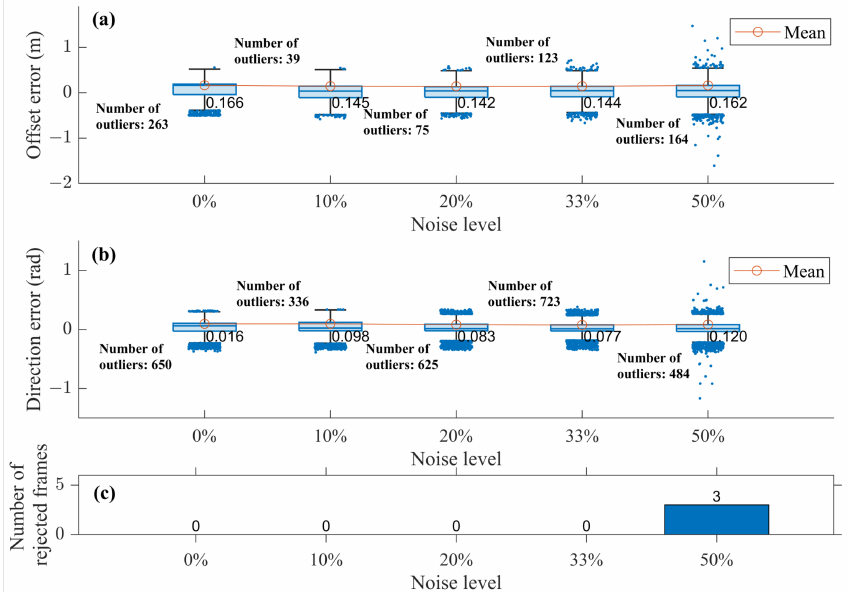
Figure 17. Result from dataset 2 with different levels of added noise: ( a ) offset error; ( b ) direction error; ( c ) number of rejected frames.